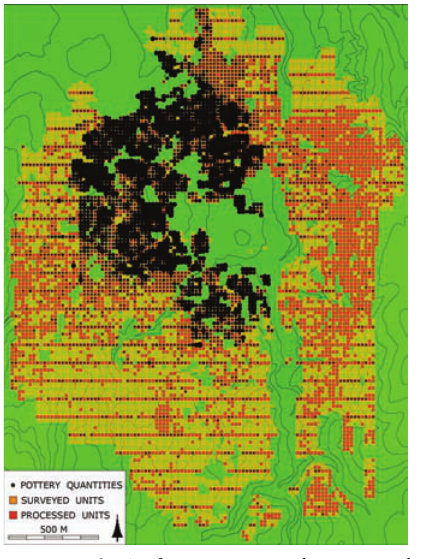
Figure 6 Surface pottery density and excavations, processed units